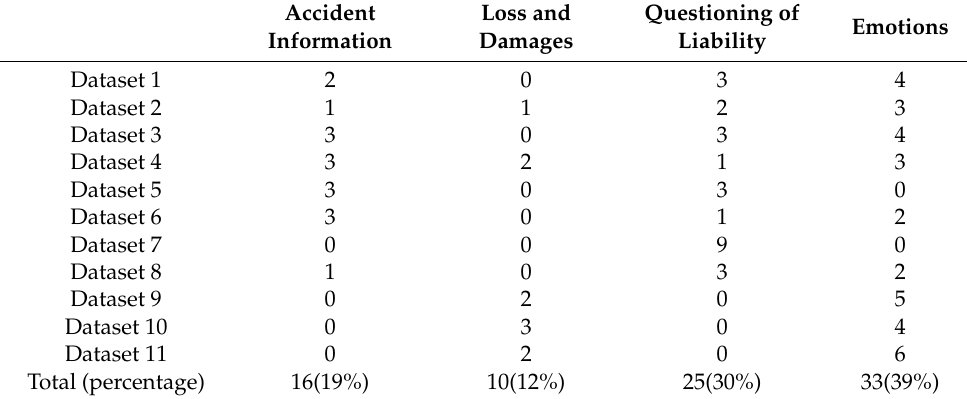
Figure 10. Partial results for the topic analysis. Table 2. Topic classification results.